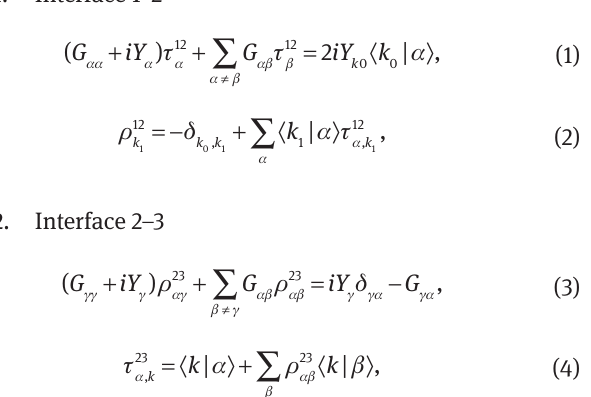
+ k n , which represents the different 0 r